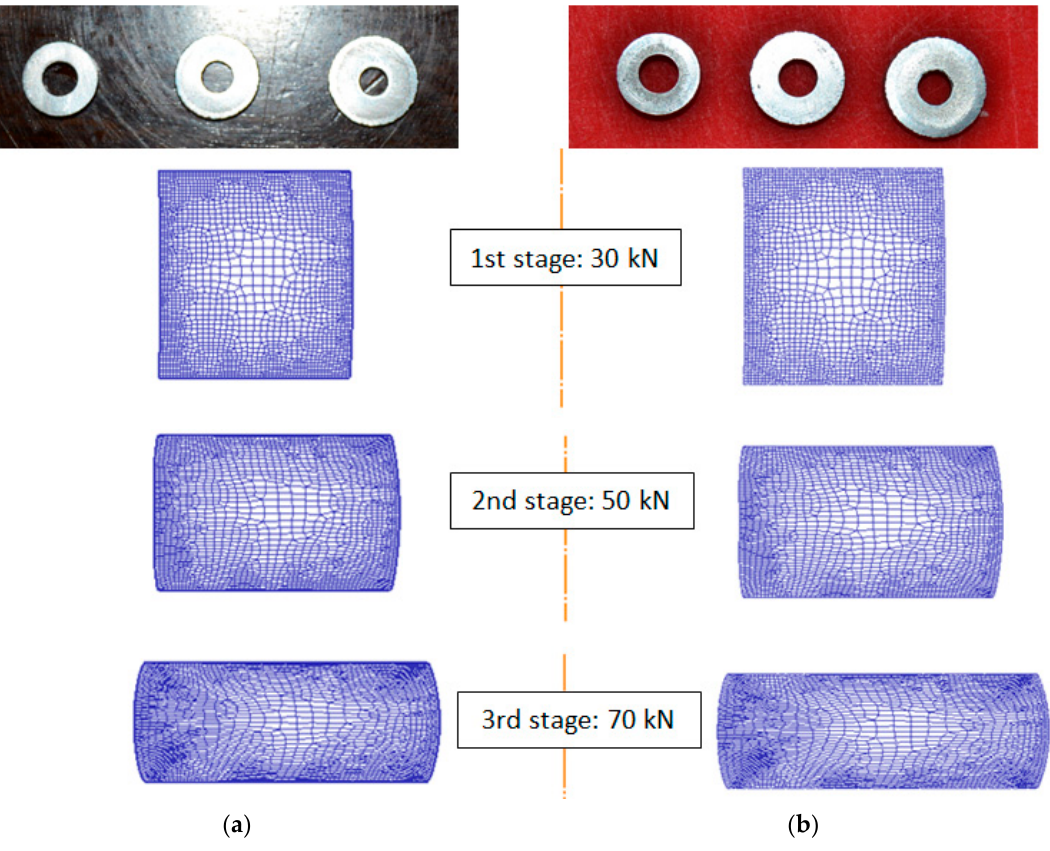
Figure 9. Comparison of experimental observations and numerical results. ( a ) Lubricant: silicone oil; ( b ) Lubricant: aluminum anti-size.